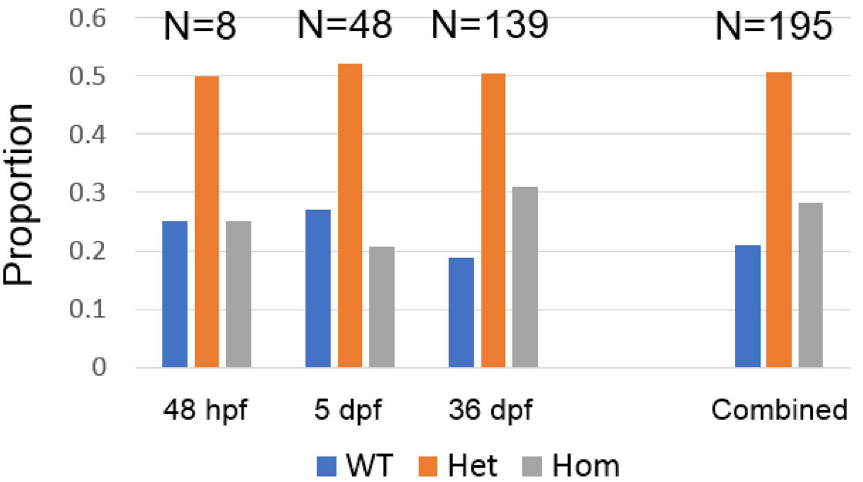
Figure 4. ppp2r3b mutants are viable at all ages. Proportions of wild-type (WT), heterozygous (Het) and homozygous (Hom) mutant ( ppp2r3b Ala31ValfsX150 ) animals at the stated ages. Total numbers of embryos analysed are